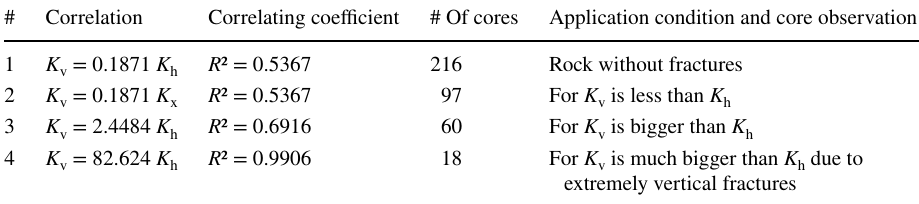
Table 1 Developed vertical # Correlation Correlating coefficient # Of cores Application condition and core permeability correlations for Arbuckle formation (Fazelalav 2013)